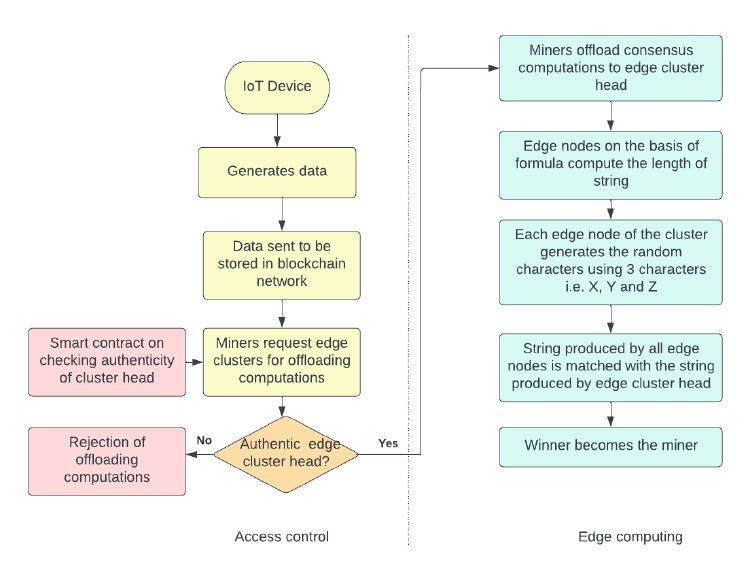
Figure 1. Workflow of the system